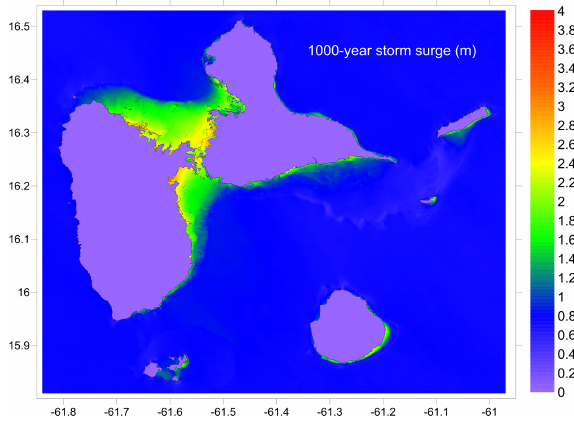
Figure 8. 1000-year surge levels in Guadeloupe (in